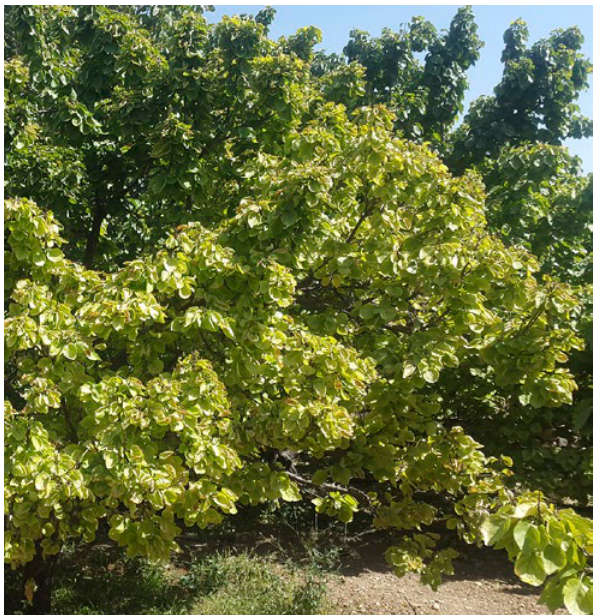
Figure 1. Apricot yellows symptoms (leaf yellowing, size re- duction and inward curling, rosette and die back) observed on apricot trees at MeshKan (Neyriz, Fars Province,